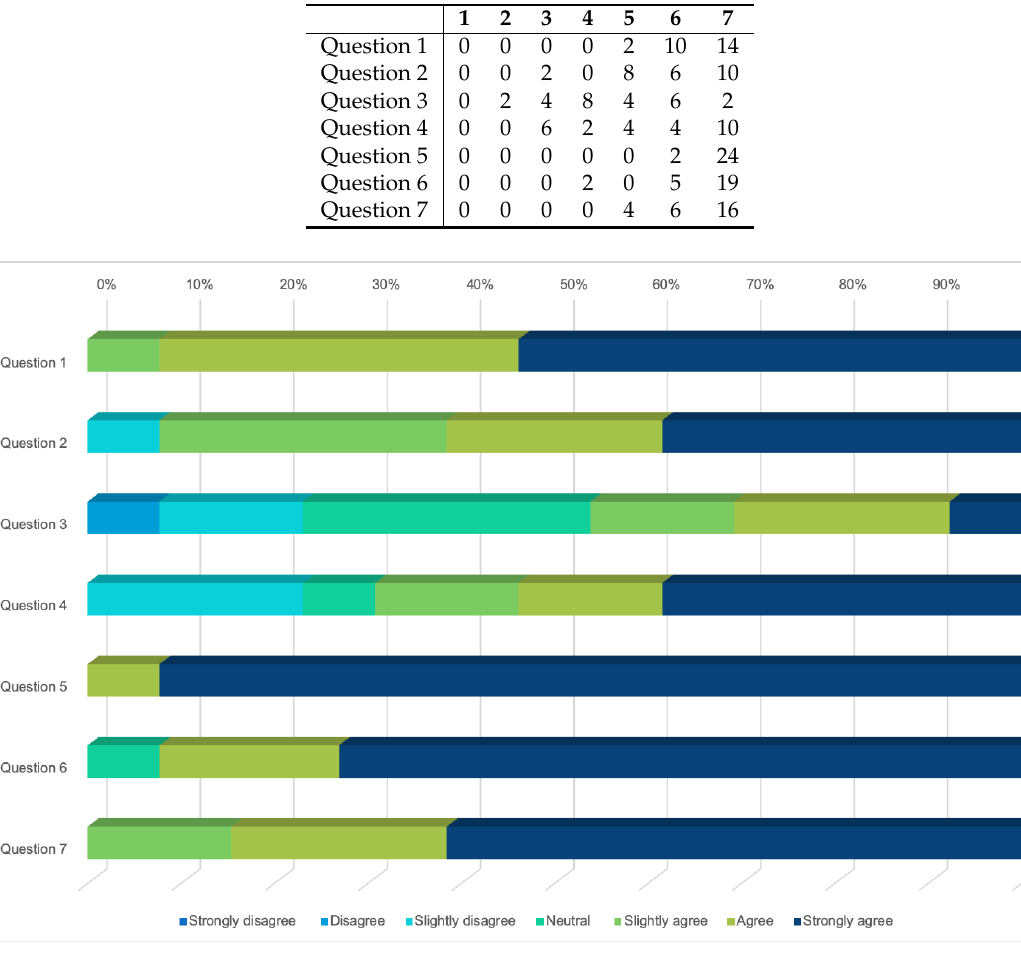
Figure 3. Bar chart of the feedback survey